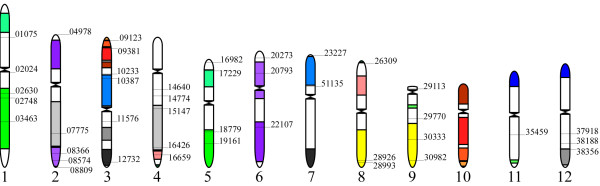
Duplication map for O. sativa ssp. japonica kinesins. Figure showing the approximated distribution of Oryza kinesins on a chromosomal duplication map based upon [94]. All accession numbers should be prefixed with "OSBCCO" if searching [100].